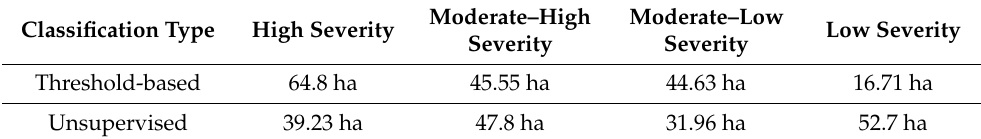
Table 3. Comparison of fire severity levels between the classifications.